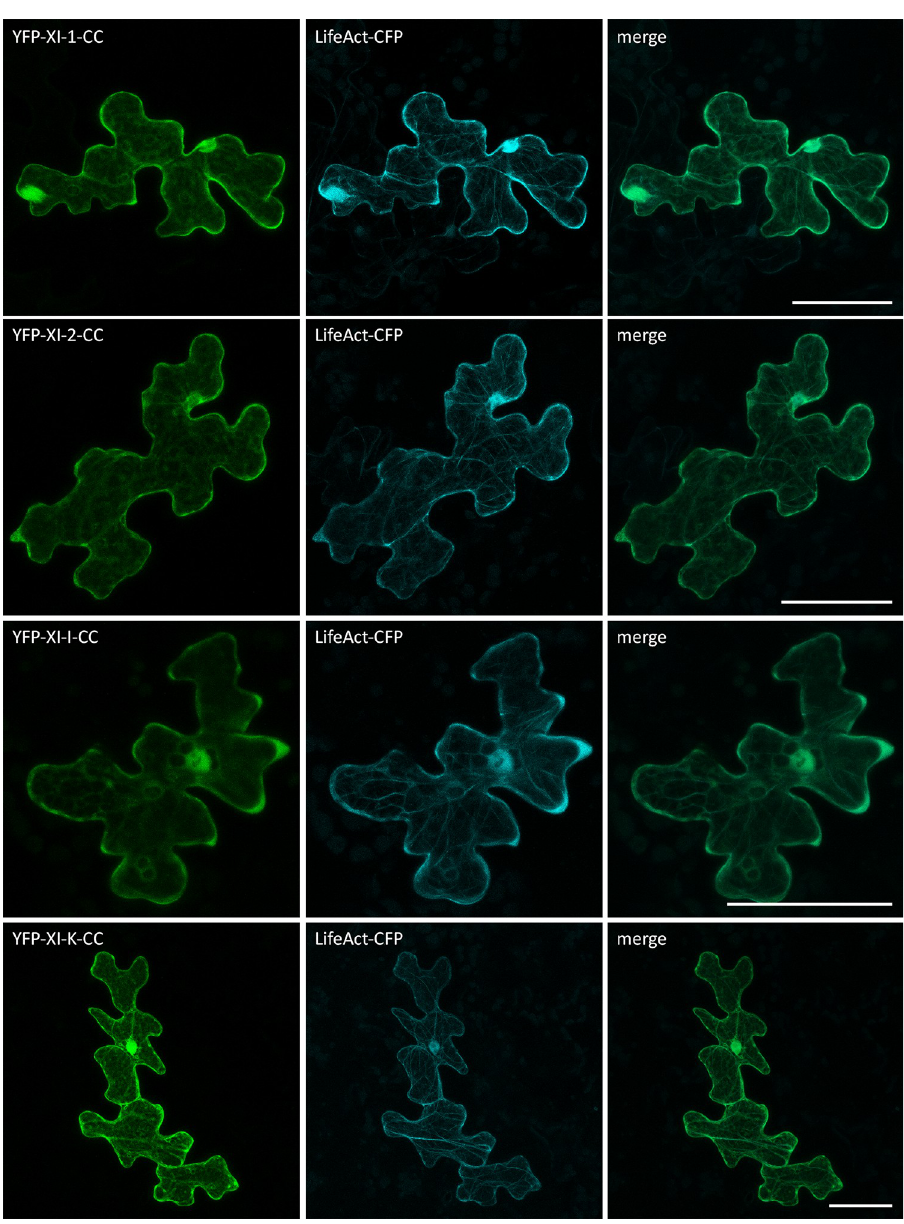
Fig 4. Co-localization of myosin coiled-coils and LifeAct in Arabidopsis epidermal cells. Transient expression of LifeAct-CFP with myosin coiled-coils in Col-0 epidermal pavement cells. The scales display 50 μ m. The GTDs did not show any co-localization with LifeAct-CFP (Fig